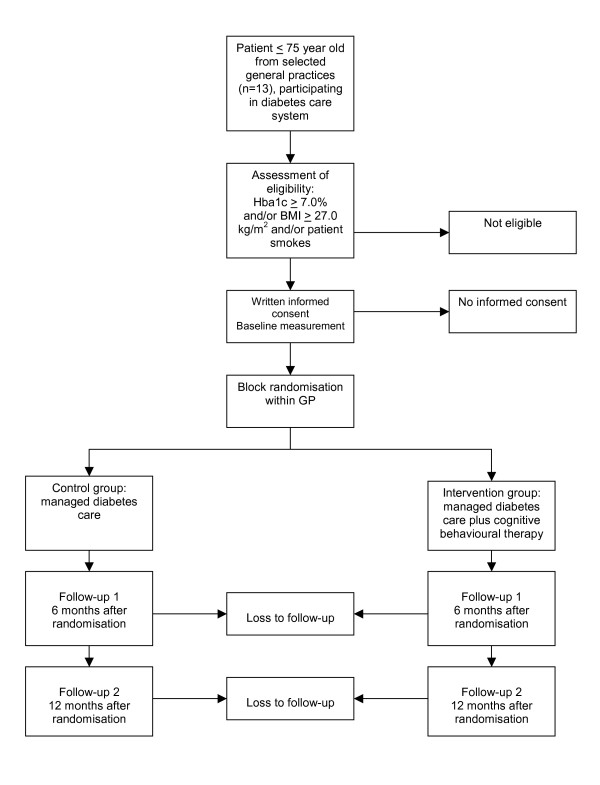
Design of the RCT.